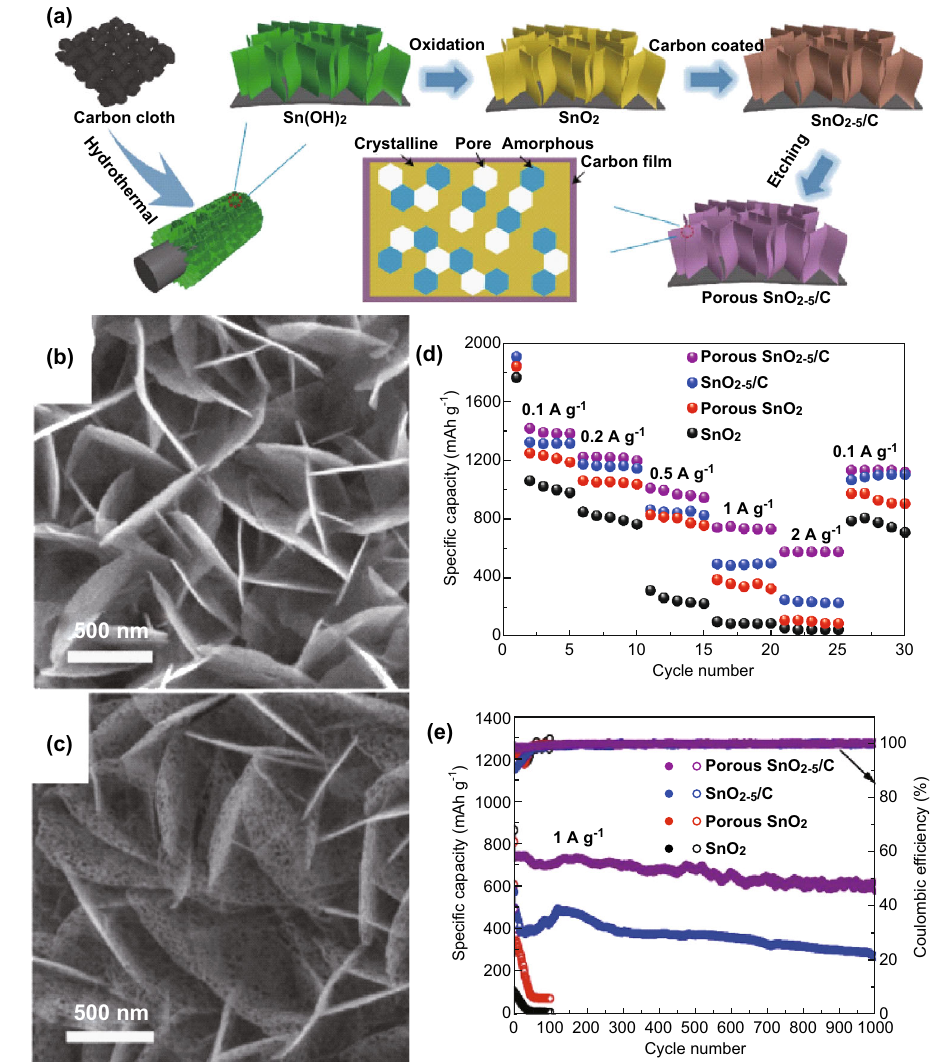
Fig. 10 3D architectures based on 2D porous SnO 2- d /C nanoflake arrays on carbon cloth substrate ensembles for LIBs. a Schematic diagram of the process for fabrication of porous SnO 2- d /C nanoflake arrays. b SEM image of porous SnO 2- d /C nanoflake arrays. c SEM image of porous SnO 2 nanoflake arrays. d Rate performance of porous SnO 2- d /C, SnO 2- d /C, porous SnO 2 , and SnO 2 nanoflake array electrodes. e Cycle performance of porous SnO 2- d /C, SnO 2- d /C, porous SnO 2 , and SnO 2 nanoflake array electrodes. Reproduced with permission [105]. Copyright (cid:2) 2018,